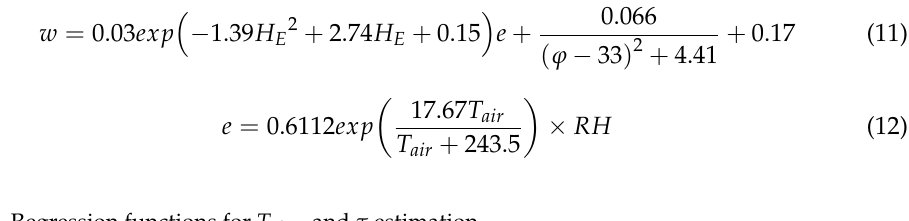
Table 5. Regression functions for T air_e and τ